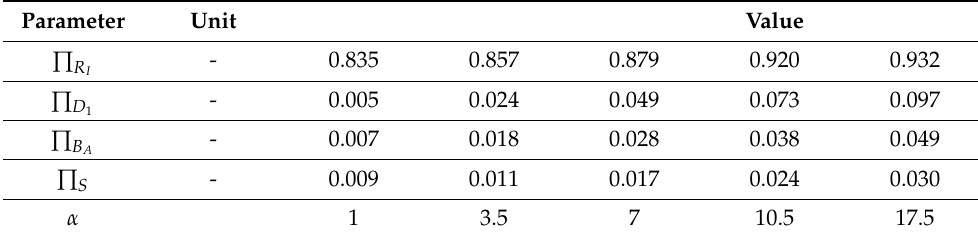
Table 4. Geometry parameter ranges for the parametric design study.